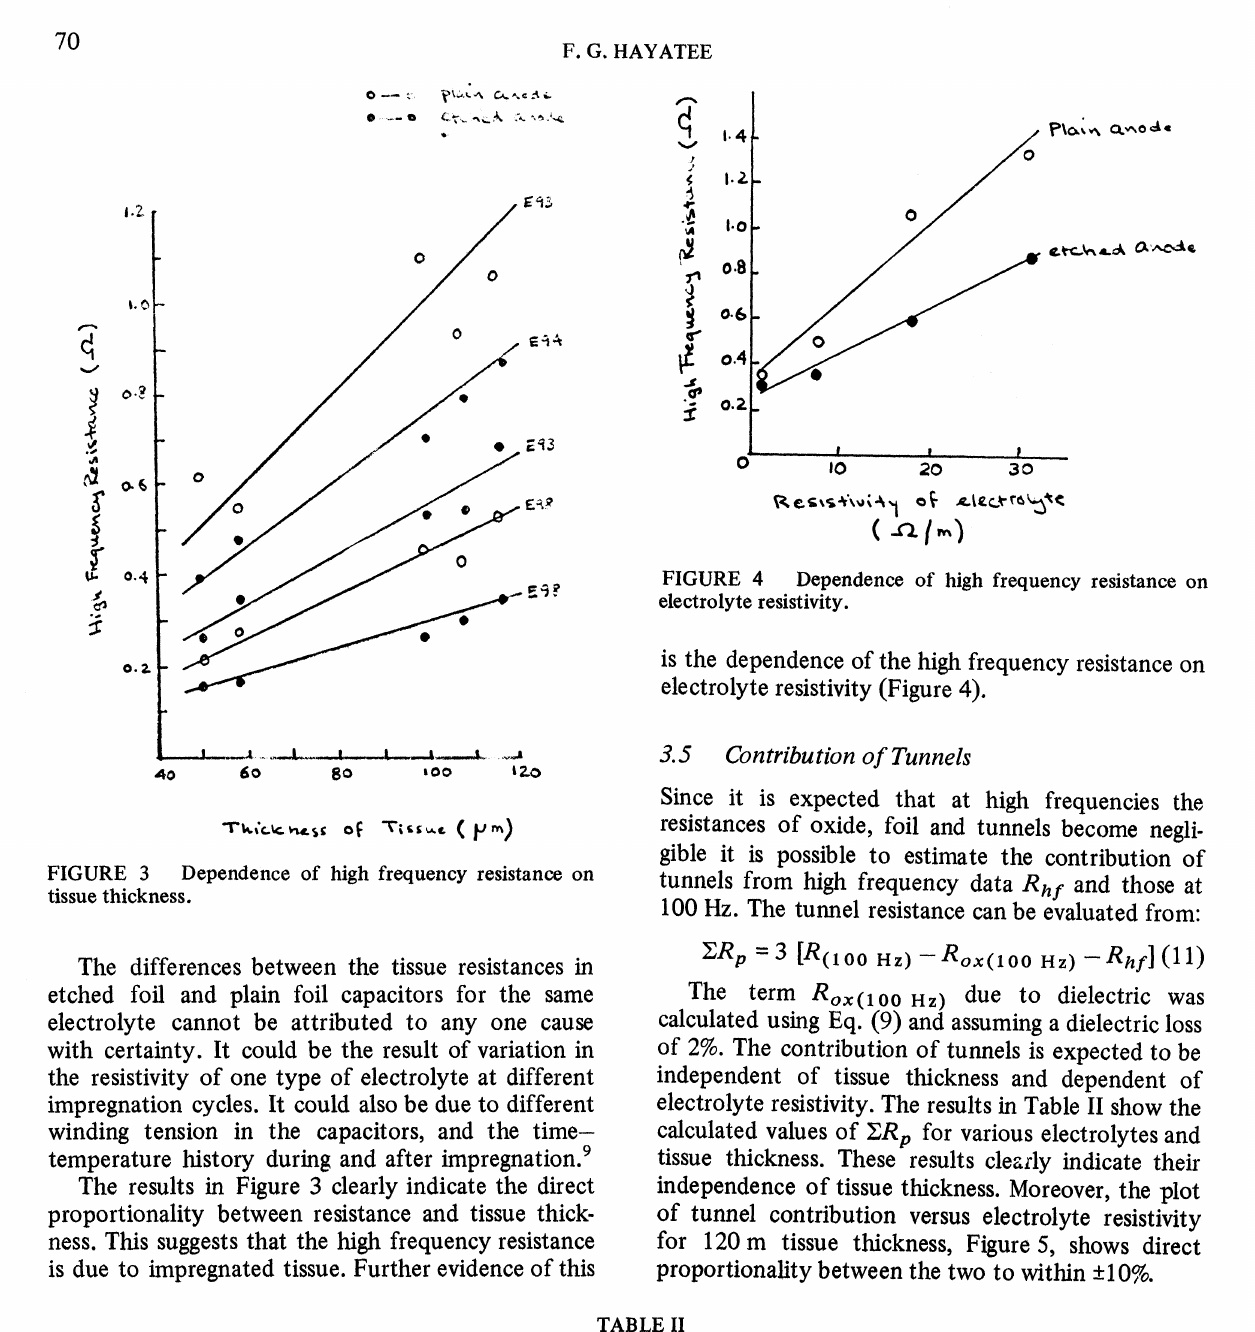
Tunnel contribution for tissue thickness